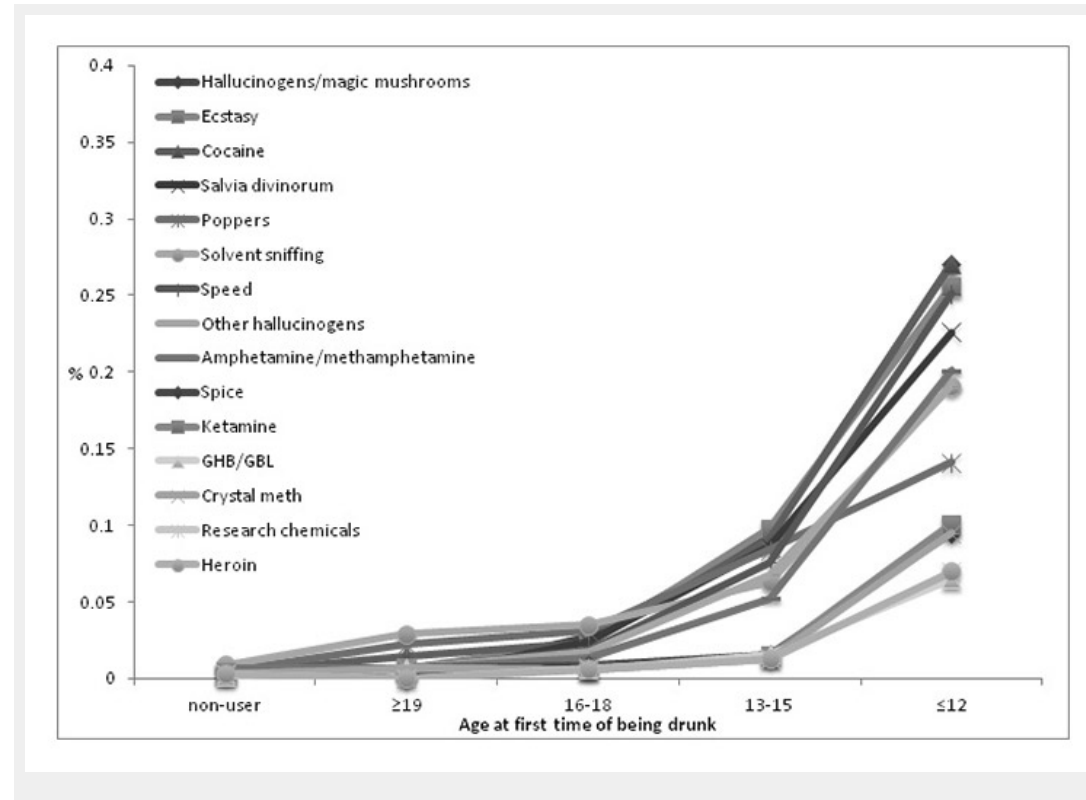
Figure 3 Prevalence rates for drug use according to age at first drunkenness.The prevalence rate for each drug is given according to the age of onset of being drunk. For example, 7.0% of the participants who first got drunk at age 12 years or earlier used heroin, whereas only 1.3% of the participants who first got drunk at age 13 to 15 used heroin (percentages can be found in table